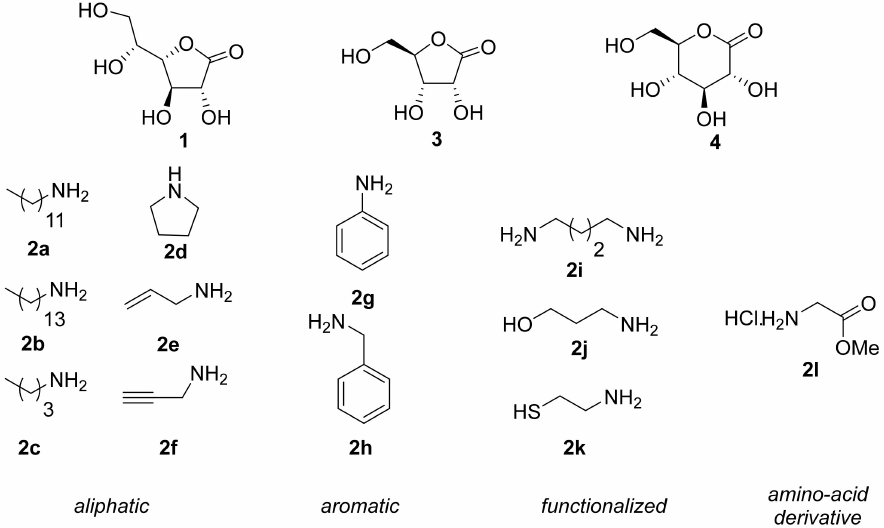
Figure 1. Glyconolactones ( 1,3,4 ) and amines ( 2a – 2m ) used in this